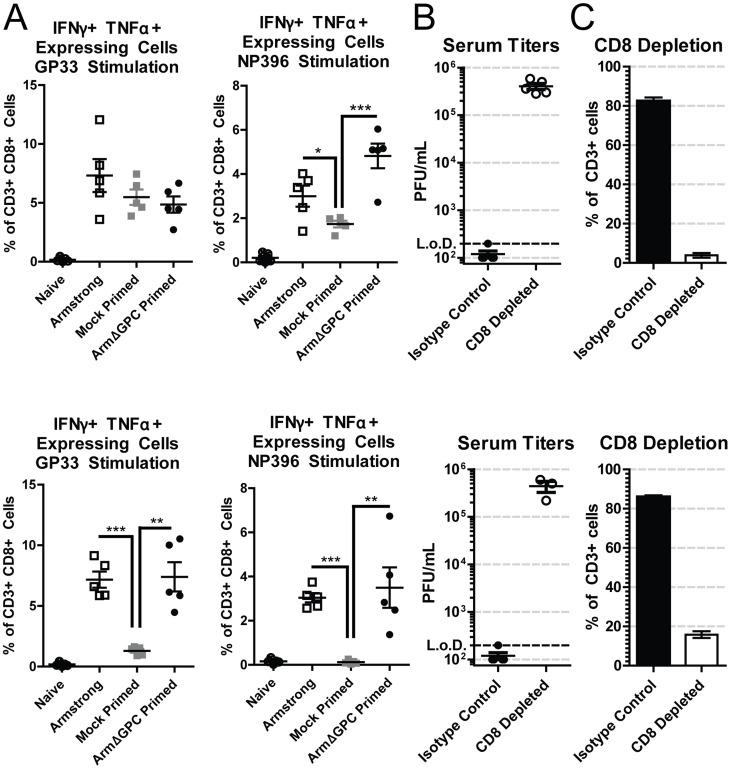
CD8+ T cells are necessary for Arm primed mediated clearance.C57Bl6/J (H-2b) mice (n = 5/group) were bled at either day 7 (top panels) or day 11 (bottom panels). A) C57Bl6/J (H-2b) mice were infected with Arm (2×106,i.v.), or mock (PBS) or Arm (2×106 ffu, i.v.) primed 12 hours before infection with Cl13 (2×106,i.v.). Blood samples were collected at 7 (top panels) or 11 (bottom panels) days post-infection and after erythrocyte depletion incubated with H-2b restricted peptides GP33–41 and NP396–404, IL-2 and BrefeldinA. Cells were stained with antibodies against mouse CD3ε, CD8a, IFNγ and TNFα and analyzed by flow cytometry. *p<0.05; **p<0.005; **p<0.0005. B and C) C57Bl6/J mice were primed with ArmΔGPC (2×106 ffu, i.v.) and 12 hours later infected with Cl13 (2×106 ffu, i.v.). Mice received intraperiotneal injections of 0.75 mg/mouse anti-CD8 antibodies at −1 and +1 days following priming. B) Virus titers in serum were determined as in Fig. 1. C) Percentages of CD8+T cells from total CD3+ cells in the blood were determined by staining erythrocyte depleted blood with antibodies against mouse CD3 and CD8 and analyzed by flow cytometry. Two mice in the CD8 depleted group died at day 10.